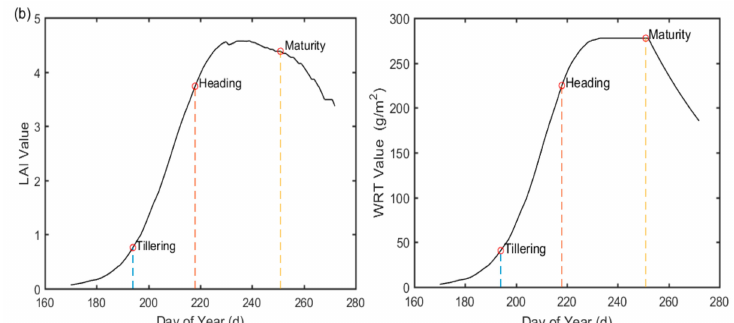
Figure 6. ( a ) The extraction of key phenological stages based on NDVI time series (tillering, heading, and maturity) in study areas A, B, and C respectively. ( b ) The simulation of Leaf Area Index (LAI) and Dry Weight of Roots (WRT) based on assimilation method of phenological